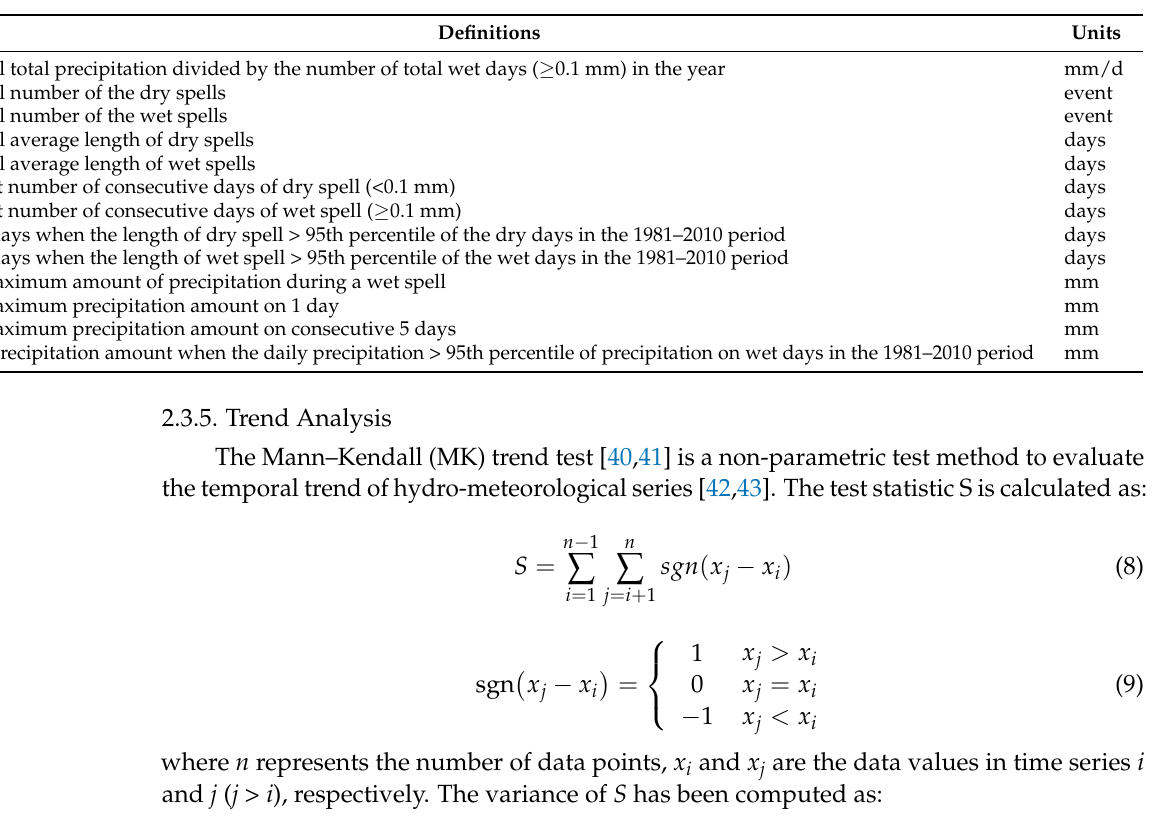
Table 1. The indices for the wet spell and dry spell indices in this